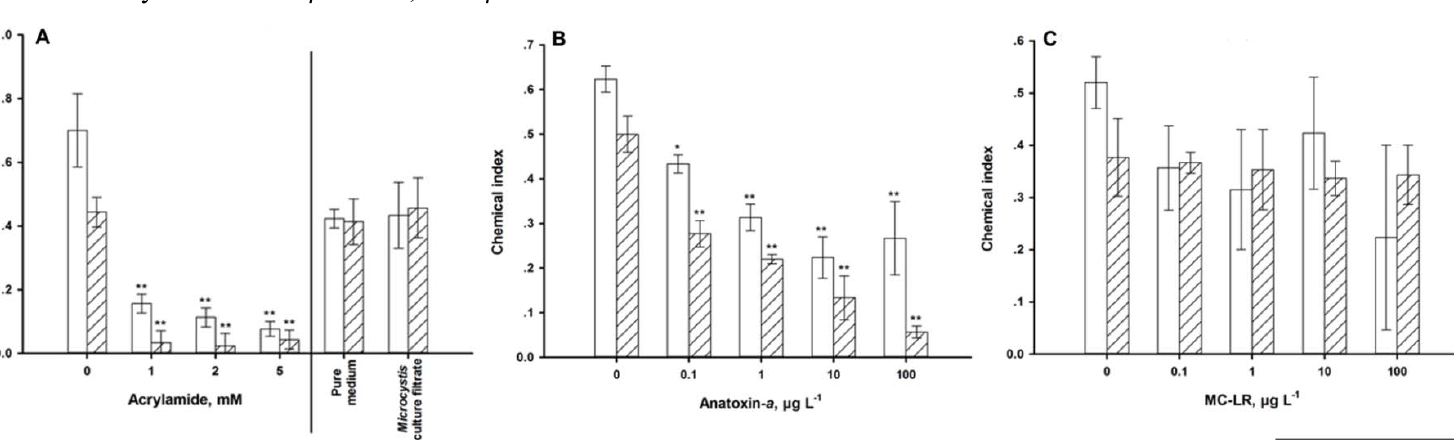
Figure 7 . Chemical sensory response of young adult nematodes after exposure for 24 h ( white ) and 72 h ( hatched ). The smaller the chemical index, the worse the chemotactic behavior. ( A ): exposure to acrylamide and a Microcystis culture filtrate. ( B ): exposure to anatoxin- a . ( C ): exposure to microcystin-LR. * = p < 0.05, ** = p < 0.01.